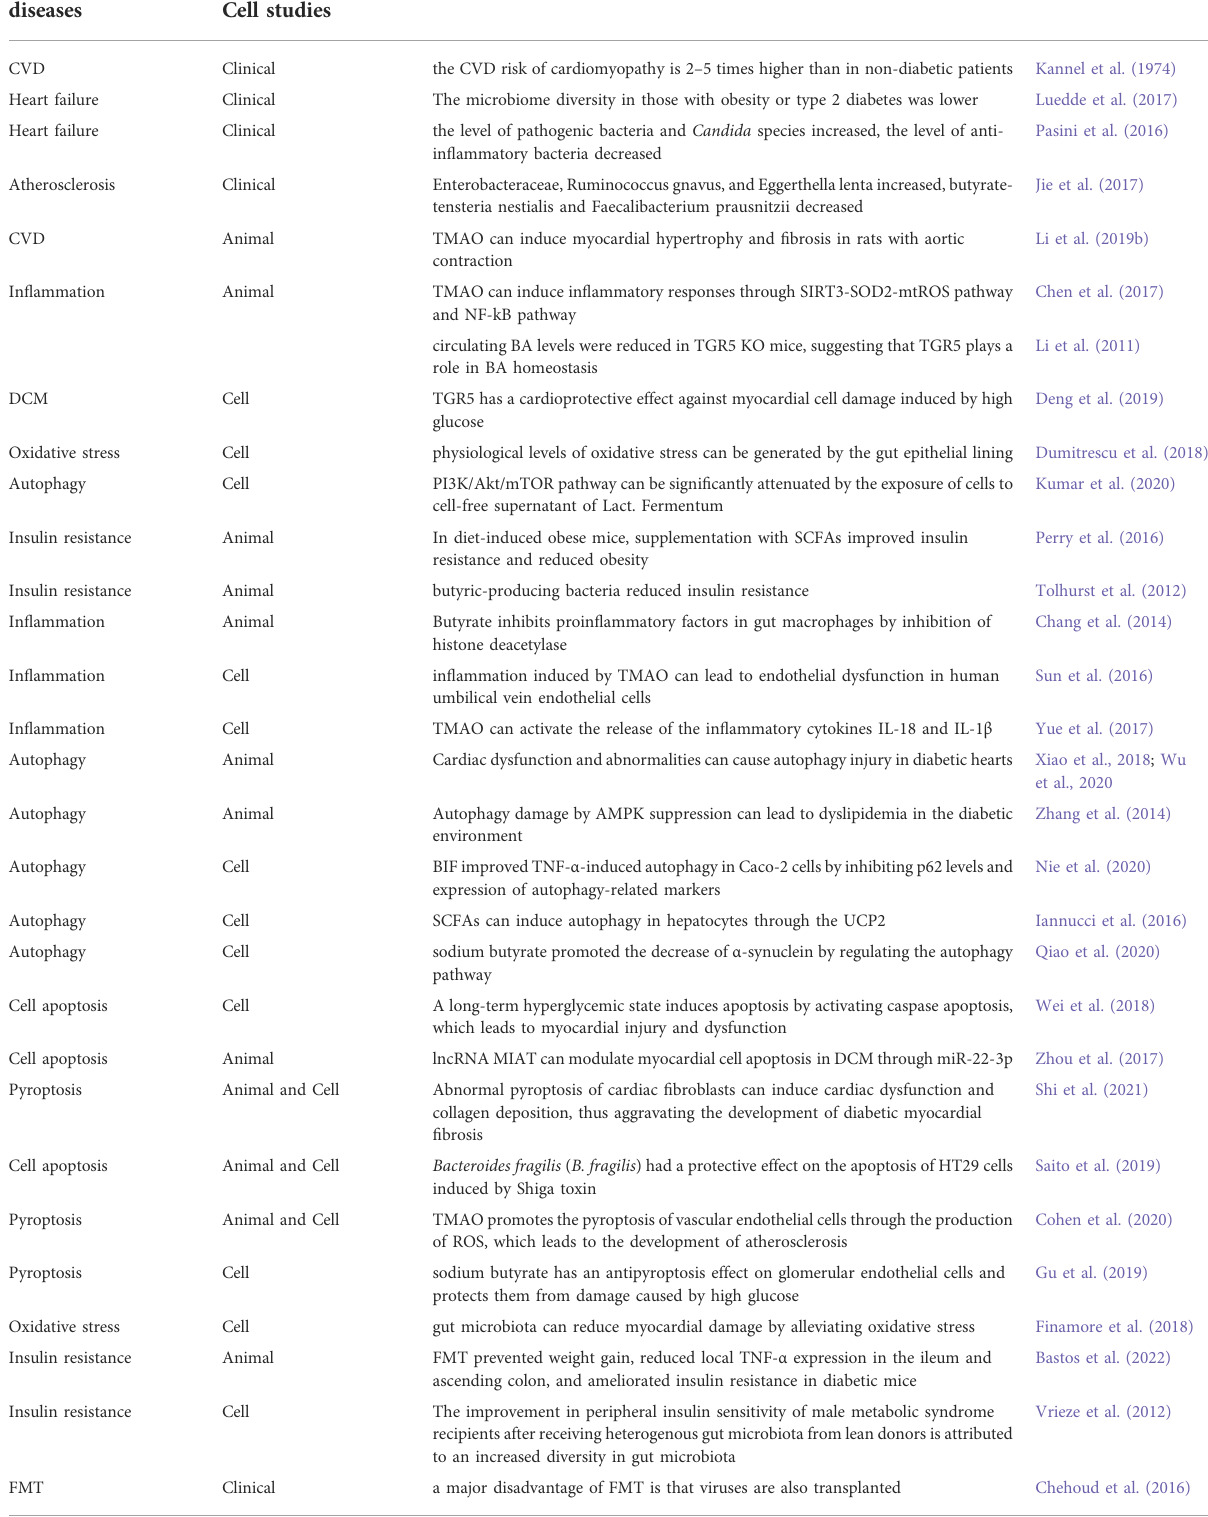
TABLE 2 Summary of fi ndings in clinical, cell and animal